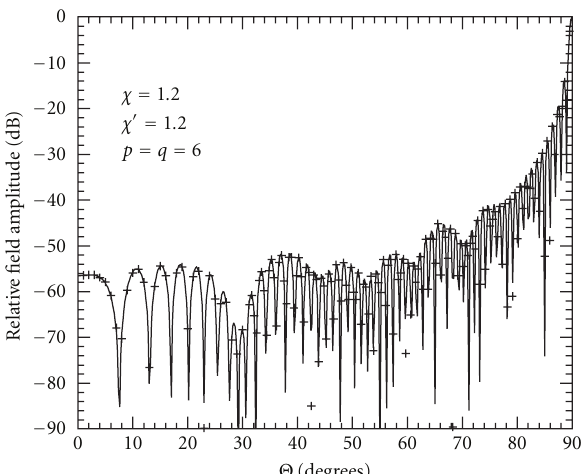
Figure 15: E-plane pattern. Solid line: exact. Crosses: reconstructed from NF data.